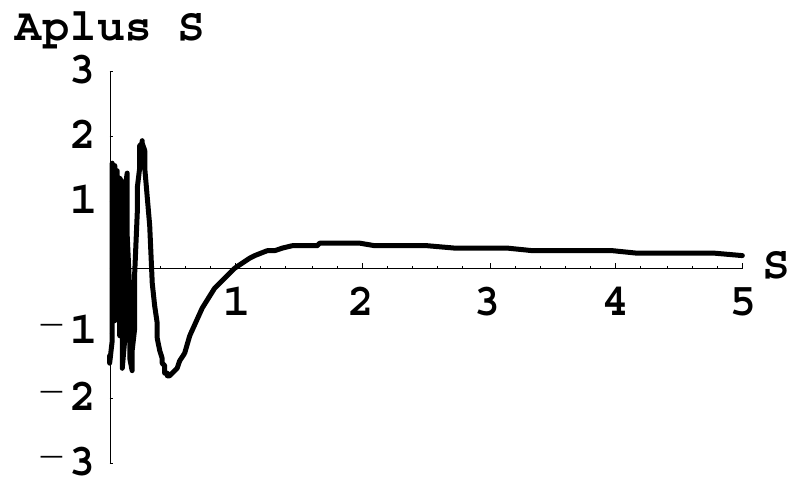
Figure 10. The integrand A + (s)/s, corresponding to the widths function a + , versus s = Z/ γ , where Z is the scaled impact parameter defined by Equation (8.2) and γ is the relativistic factor, as defined by Equation (8.3) [82].